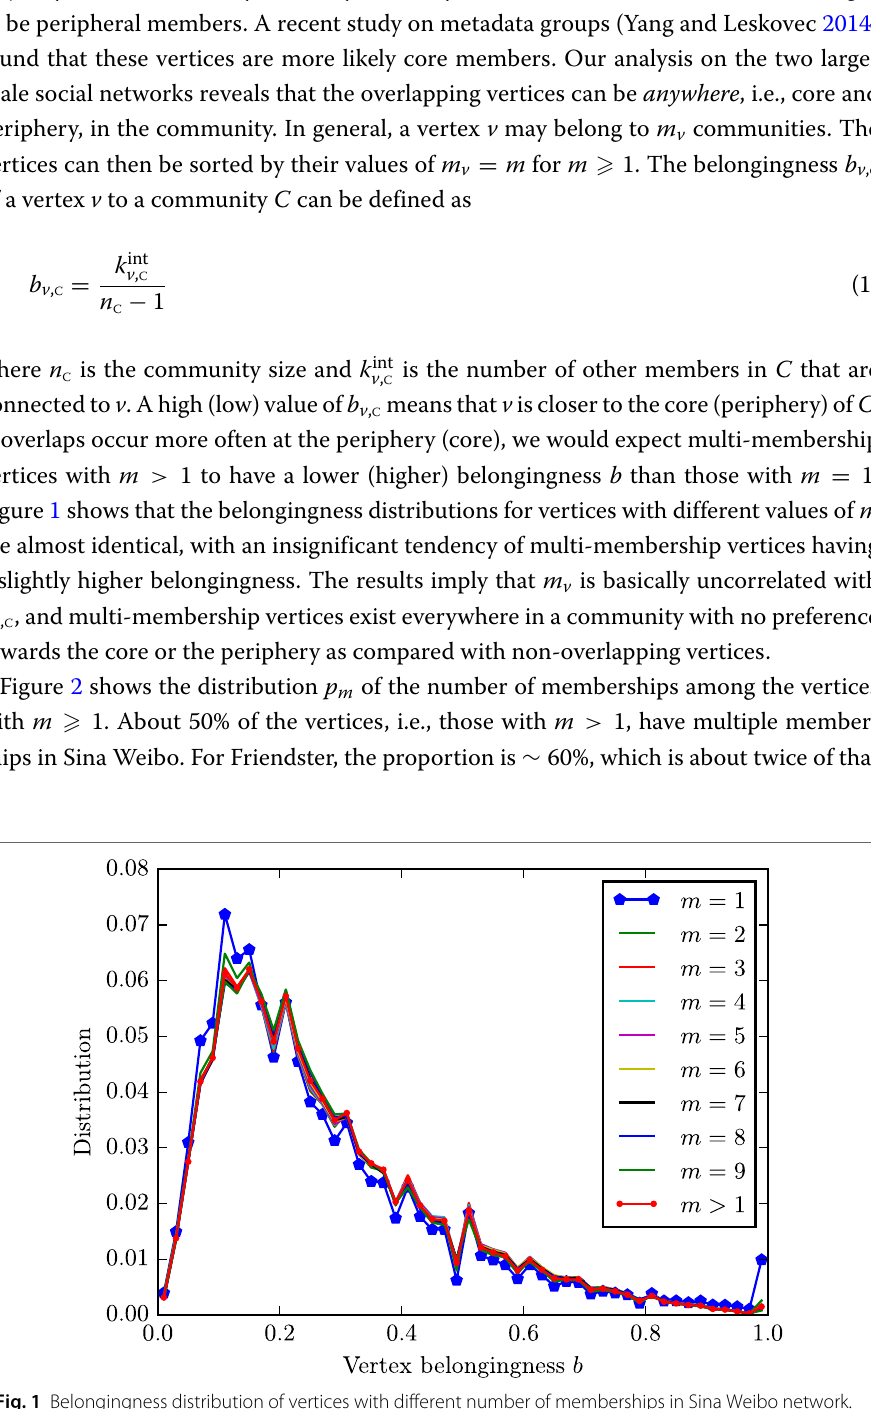
Fig. 1 Belongingness distribution of vertices with different number of memberships in Sina Weibo network. The bin width of the x-axis is 0.02. A vertex with m memberships has m independent values of belongingness b , each for a community that the vertex belongs to. The distributions are almost the same, i.e. uncorrelated to m , for different values of m , with m = 1 shifted slightly to the left. The noisy peaks are due to the fact that belongingness b as defined in Eq. (1) is discrete, especially when n C is small. The Friendster network (not shown) shows the same